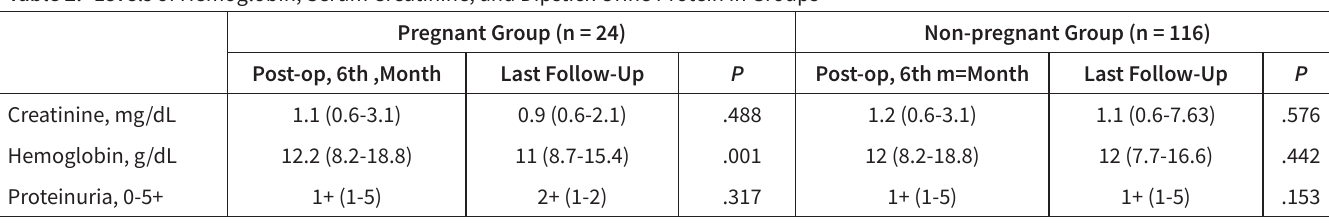
Table 2. Levels of Hemoglobin, Serum Creatinine, and Dipstick Urine Protein in Groups